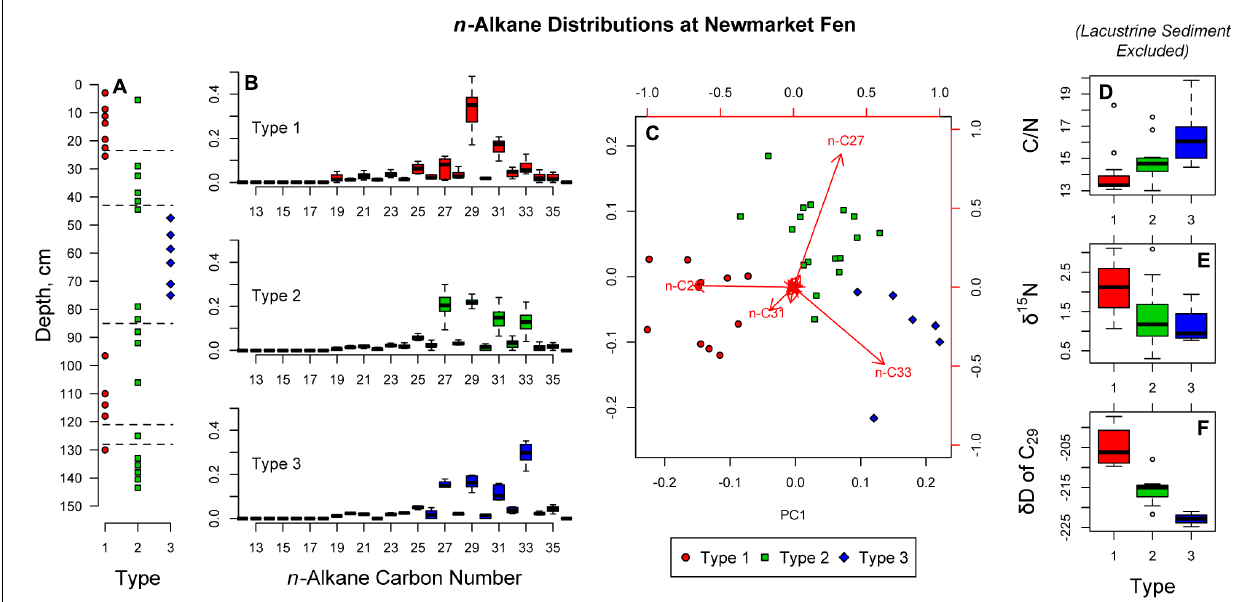
FIGURE 3 | Results of hierarchical cluster analysis and principal components analysis on the relative abundances of leaf wax n -alkanes. (A) Type assignments by core depth; (B) Box-and-whisker plots of n -alkane relative abundance for each type; (C) Principal components analysis biplot. Point color and shape are determined by hierarchical cluster analysis; (D–F) Box-and-whisker plots of C/N ratio, δ 15 N, and hydrogen isotope ratios of C 29 n -alkane. For all box-and-whisker plots, the heavy line in the center is at the median, the shoulders of the box indicate the interquartile range, the whiskers extend to the most extreme data not more than 1.5 times the interquartile range, and the points beyond 1.5 times the interquartile range from the box are indicated with